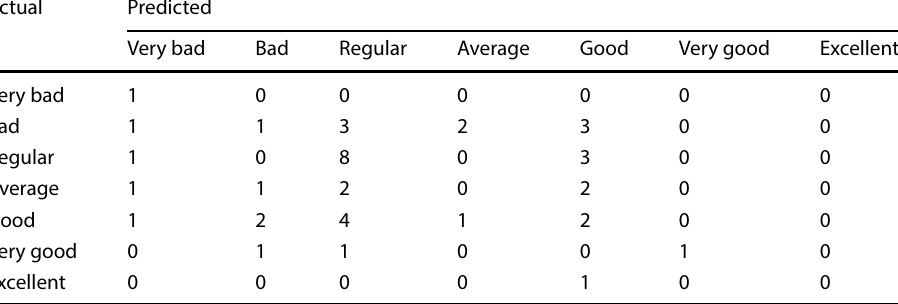
Table 5 Classification confusion matrix via artificial neural network using numerical values as input data for categorical predicting (considering only the test